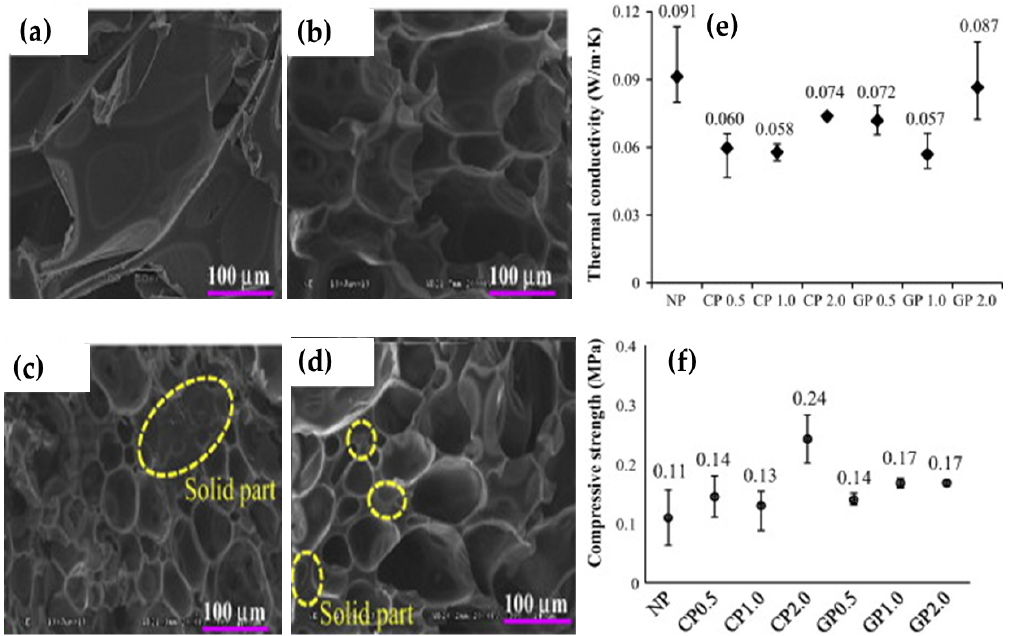
Figure 13. Scanning electron microscope images of ( a ) neat phenolic foam (NP), ( b ) phenolic foam with 0.5% multi-wall carbon nanotube (CP 0.5), ( c ) phenolic foam with 2% multi-wall carbon nanotube (CP 2.0), ( d ) phenolic foam with 2% graphene (GP2.0), ( e ) thermal conductivity, and ( f ) compressive strength of produced foams with respect to the particle type and weight fraction. Reprinted with permission from the authors of [68]. Copyright © (2014) Elsevier.